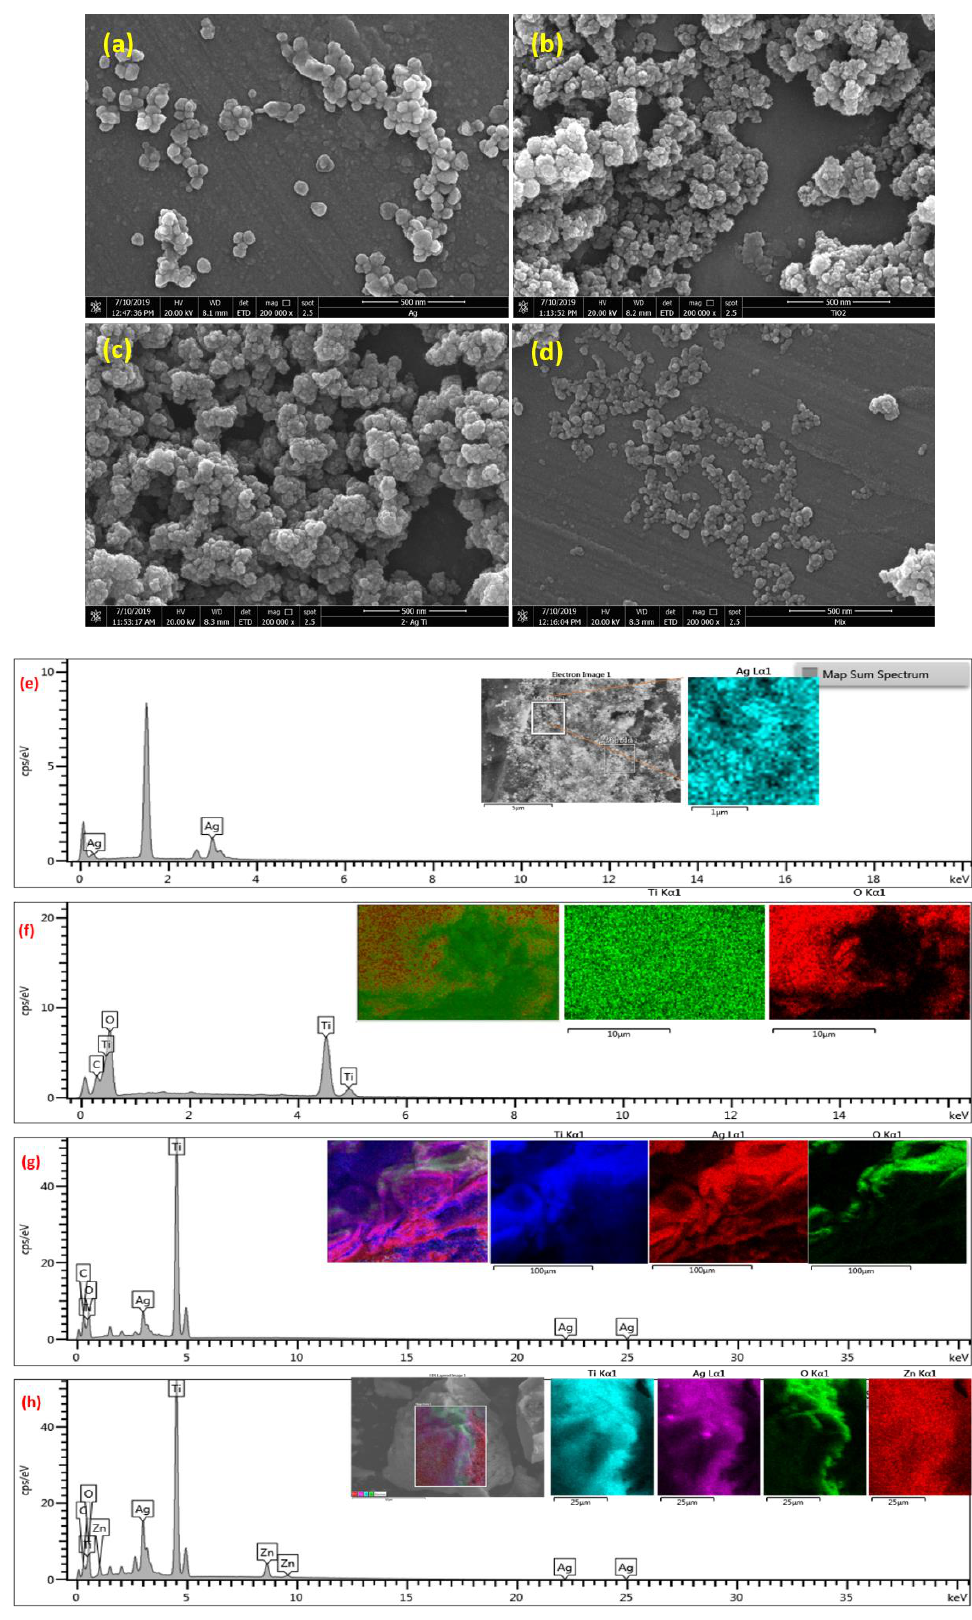
Figure 4. FESEM images of AgNPs ( a ), TiO 2 NPs ( b ), TiO 2 /AgNCs ( c ) and ZnO/TiO 2 /AgNCs ( d ). EDX analysis (Elemental mapping + Elemental composition) detection of AgNPs ( e ) TiO 2 NPs, ( f ) TiO 2 /AgNCs, ( g ) and ZnO/TiO 2 /AgNCs ( h ).